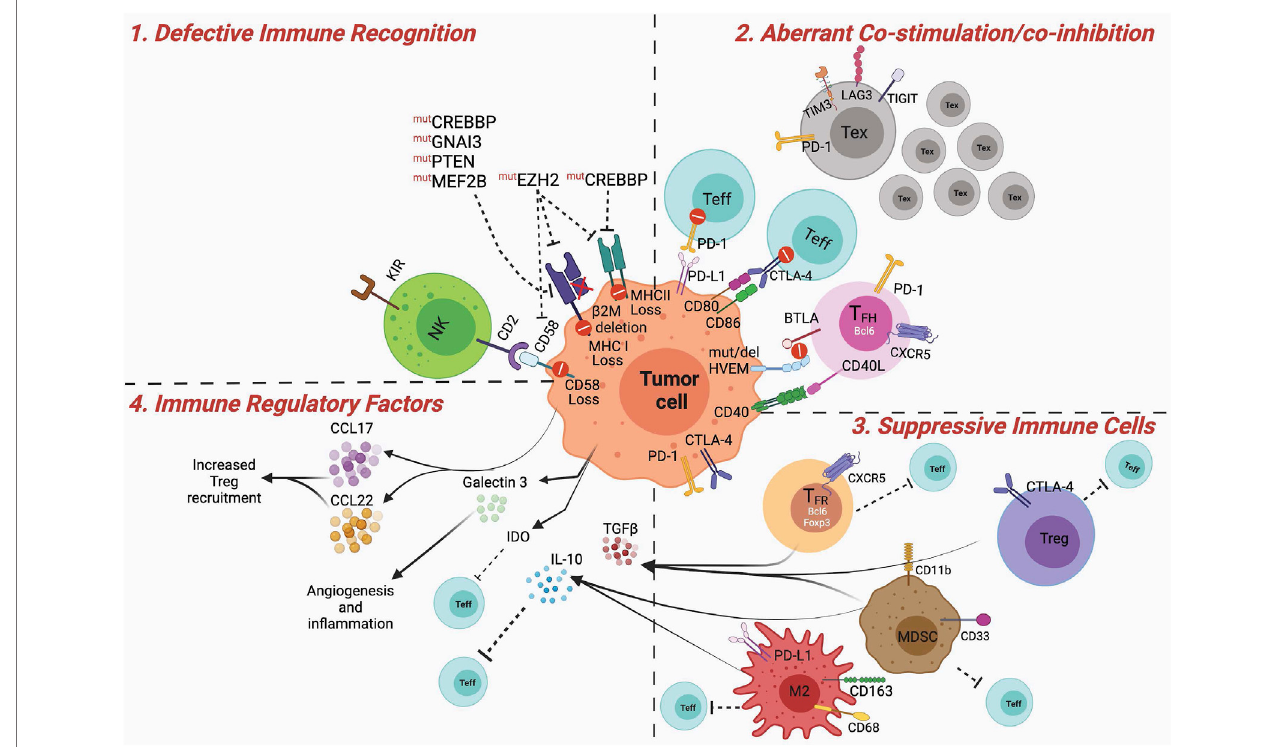
FIGURE 2 | Dysfunctional immune microenvironment in GCB Lymphomas. Major mechanisms contributing to a dysfunctional and suppressive immune microenvironment in GCB lymphomas. 1) Defective immune recognition: MHC-I and MHC-II expression are often downregulated in GCB lymphoma cells, via mechanisms involving various genetic and epigenetic mutations, leading to poor antigen recognition. In addition, disruption of CD58/CD2 axis impedes tumor recognition by NK cells. 2) Aberrant co-stimulation: PD-1 and CTLA-4 can be expressed on tumor-in fi ltrating effector T cells (Teff) limiting or counteracting their activation via signals received by PD-L1 or inhibition of CD80/CD86 mediated co-stimulation. Tumor B cells can directly express PD-1 and CTLA-4 contributing to dampening T-cell activation. Mutation or deletion of HVEM on the lymphoma cells, renders them non-reactive to BTLA expressing T FH cells, and leads to aberrant expansion of lymphomagenic population (see text for more details). Lymphogenic B cells can proliferate independent of CD40/40L-mediated T FH cell help. Tumors are in fi ltrated by large numbers of exhausted T cells that, expressing TIM3, LAG3 and TIGIT, are subjected to sub-optimal co-stimulation and activation. 3) Suppressive immune cells: Tregs, T FR , M2 macrophages and MDSCs suppress activation of Teff cells. This can be mediated by receptor ligand interaction, such as PD-1:PD-L1, CTLA-4:CD80/CD86 or via soluble factors. 4) Immune regulatory factors: IL-10, TGFb, IDO secreted by MDSCs, macrophages, Tregs, T FR , or tumor cells induce